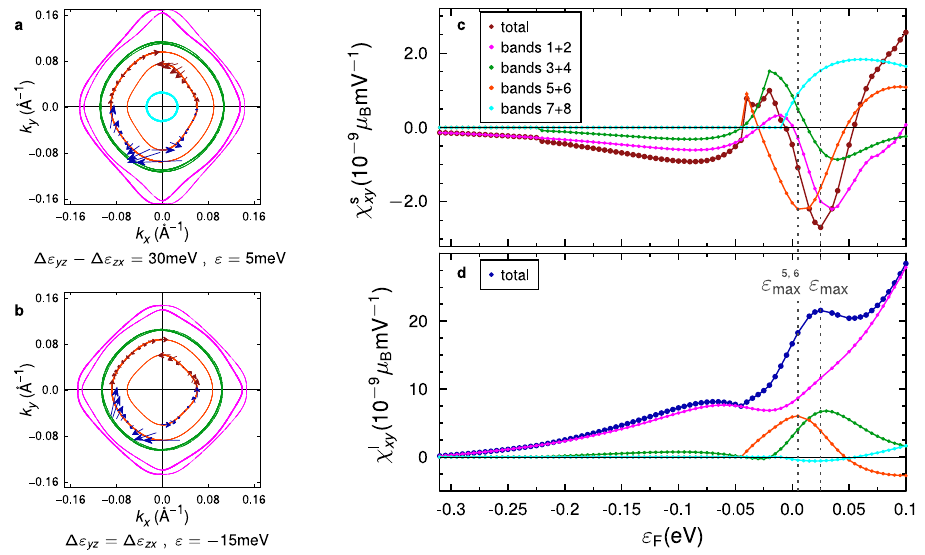
Fig. 4 | In fl uence of anisotropy on the iso-energy lines and the calculated Edelstein ef fi ciency. a shows the iso-energy lines of a system with Δ ϵ yz − Δ ϵ zx = 30meV at ϵ =5meV, which corresponds to the energy of the maximum contibu- tionofthethirdbandpair(orange)tothespinEdelsteineffect. b sameas a ,butfor